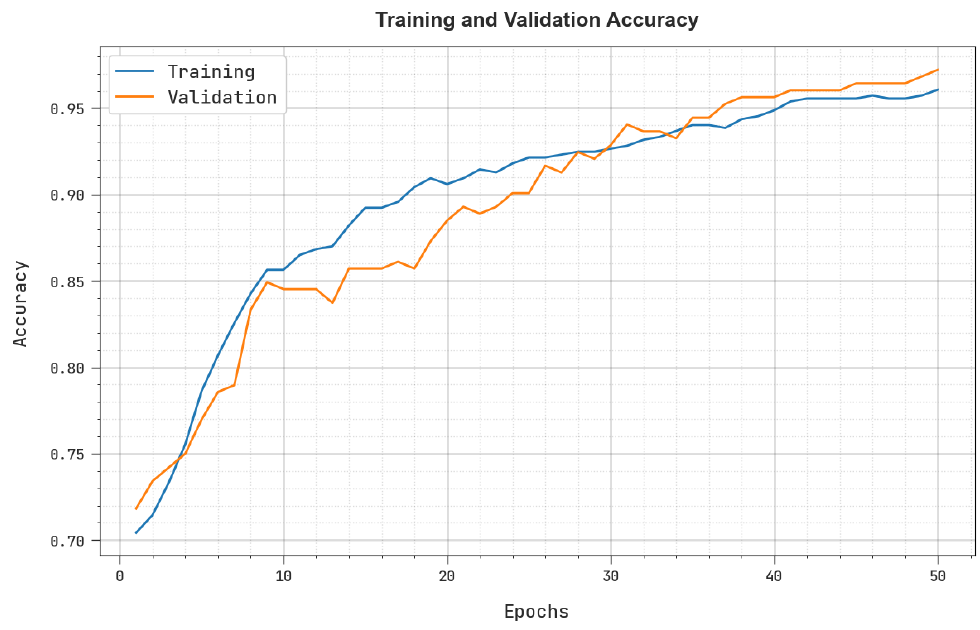
Figure 10. TRA and VLA analysis of the RFER-EADL algorithm.